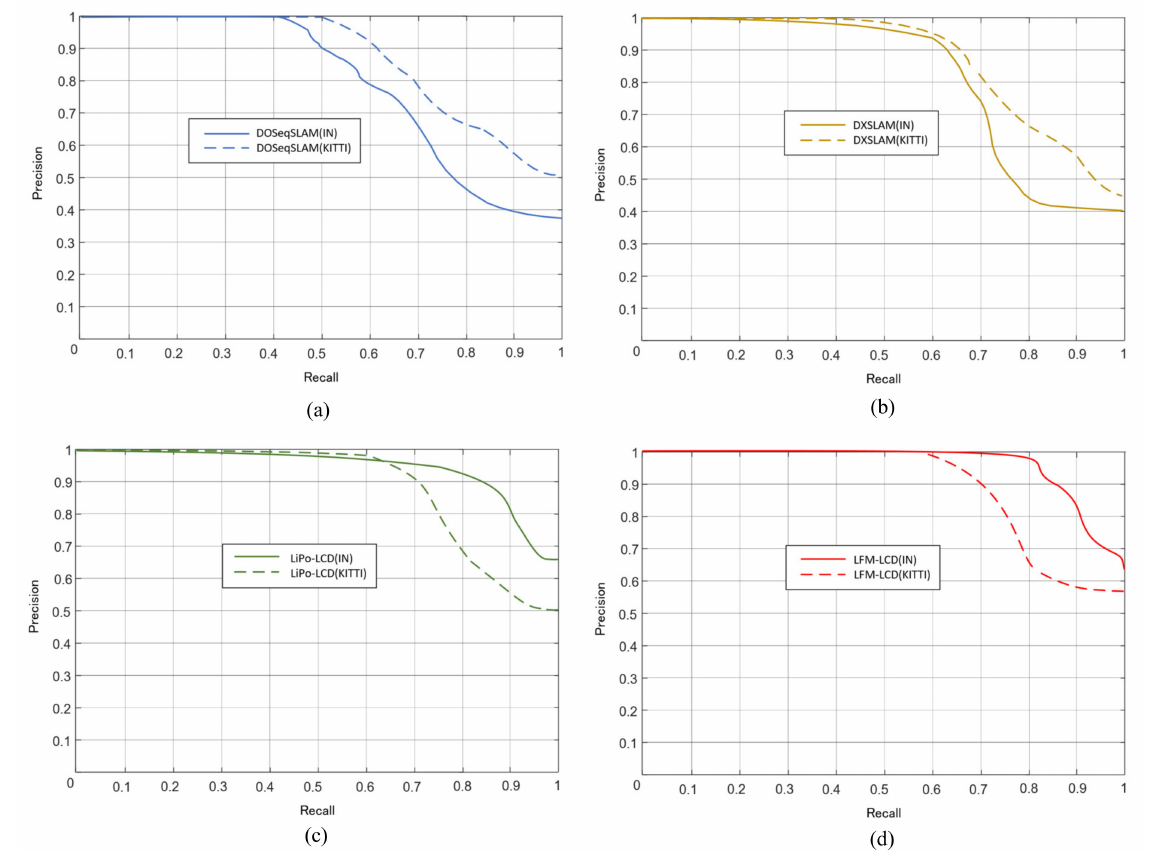
Figure 10. The RP-Curves of different LCD methods in different datasets. IN denotes the ICL-NUIM datasets and KITTI denotes the KITTI 05 datasets; ( a ) shows the RP-Curves of DOSeqSLAM; ( b ) shows the RP-Curves of DXSLAM; ( c ) shows the RP-Curves of LiPo-LCD; ( d ) shows the RP-Curves of